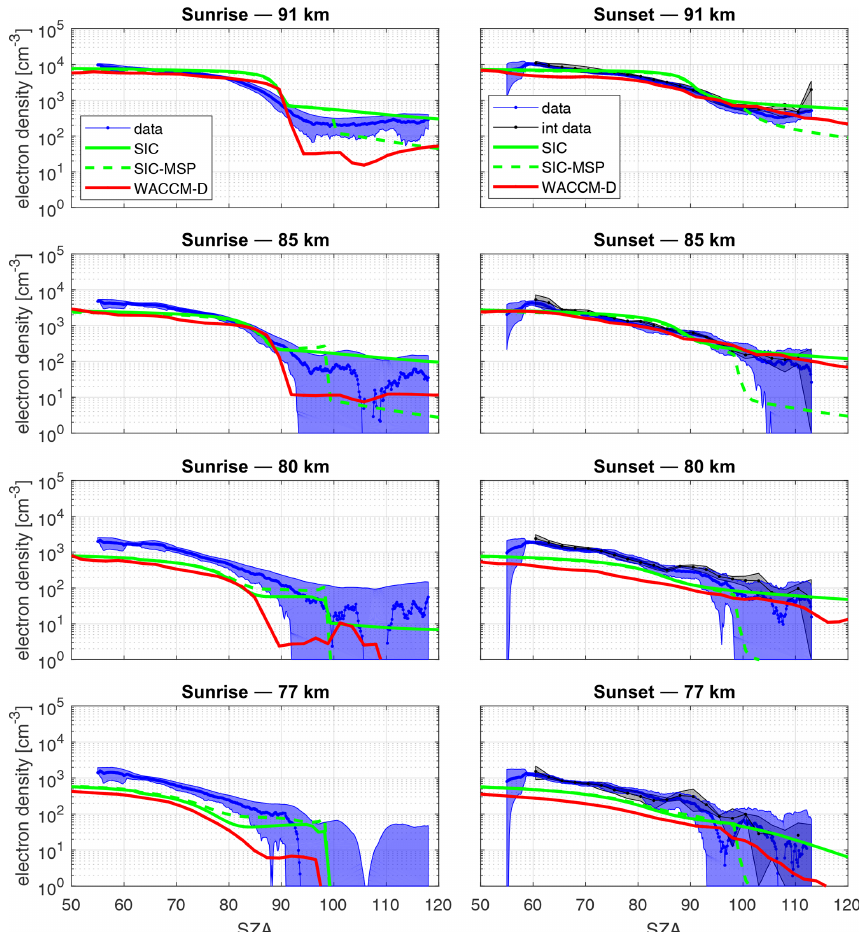
Figure 3. Comparison of measured electron densities with model results from the SIC and WACCM-D model for sunrise (left) and sunset (right) at 91, 85, 80, and 77km altitude. The blue line is the 20-point running mean of the measurements, and the blue area is the corresponding standard deviation. Green lines indicate the SIC model in its standard version (solid) and with meteoric smoke particles incorporated into the ion chemistry (dashed). WACCM-D results are given in